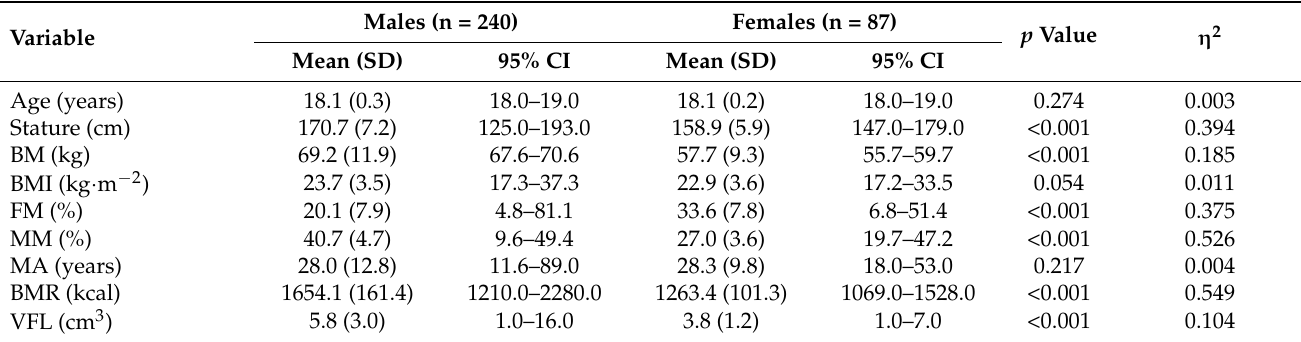
Table 1. Descriptive statistics of the undergraduate students by